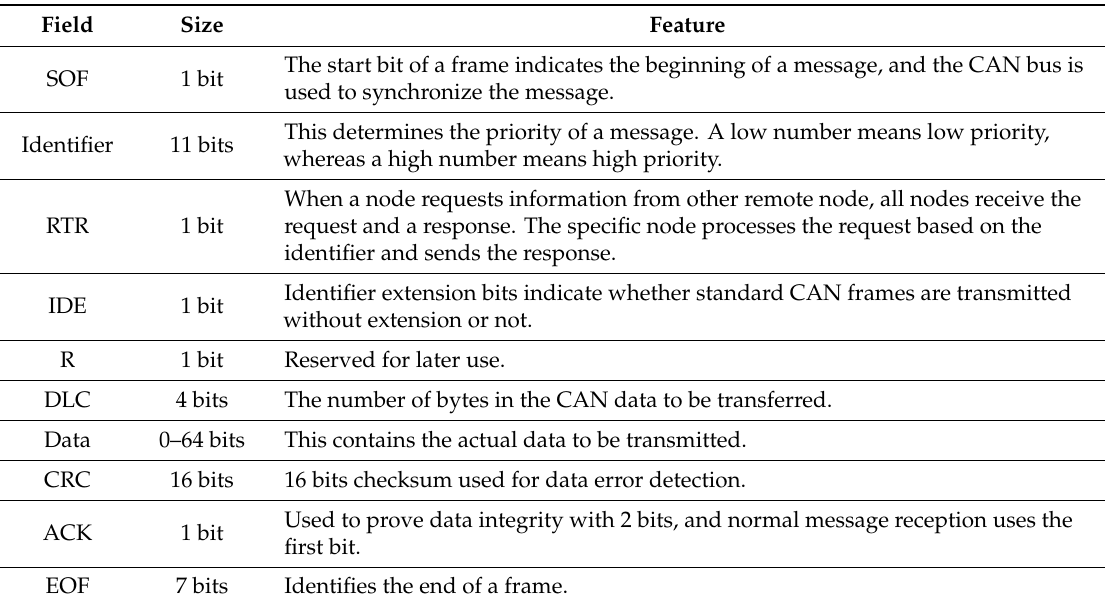
Table 1. Description of the controller area network (CAN) data frame